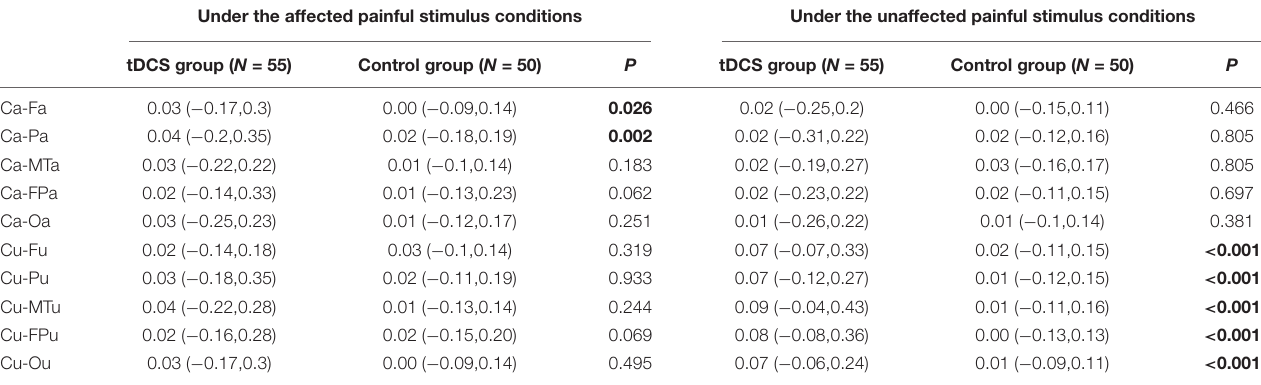
TABLE 4 | Changes in the cross approximate entropy (C-ApEn) difference between the painful stimulus conditions and the eyes-closed condition before and after the treatments. Under the affected painful stimulus conditions Under the unaffected painful stimulus conditions